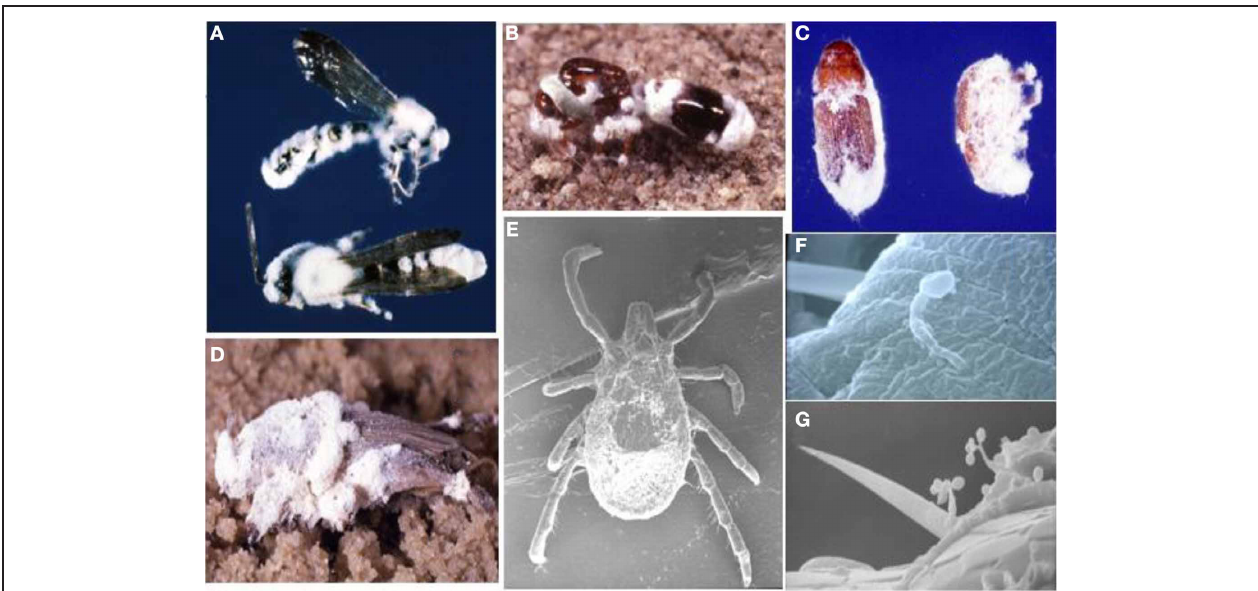
FIGURE 1 | B. bassiana has an exceptionally broad host range that spans across Arthropoda classes, from insects including; wasps (A), fire ants (B), bark beetles (C), and mole crickets (D) to arachnids such